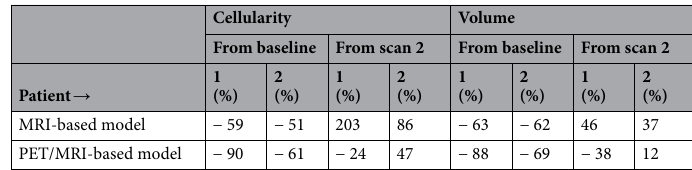
Cellularity Volume From baseline From scan 2 From baseline From scan